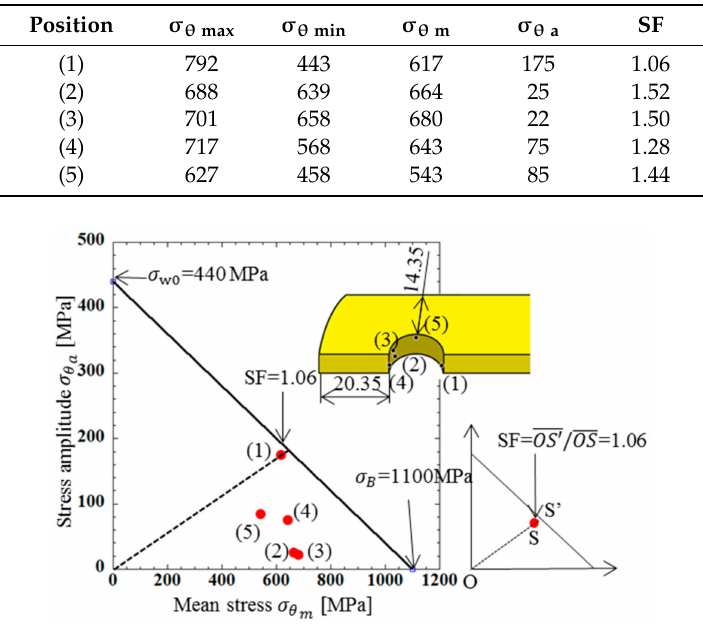
Figure 11. Fatigue limit diagram for outer plate